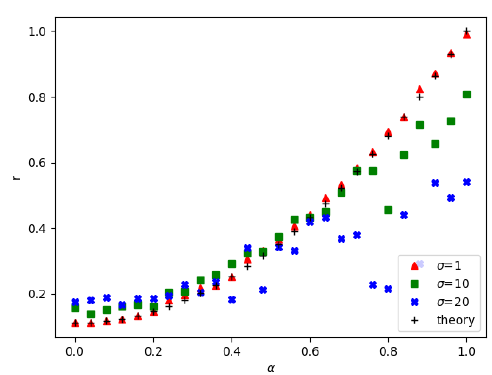
Figure 10. Comparison of purity when N =